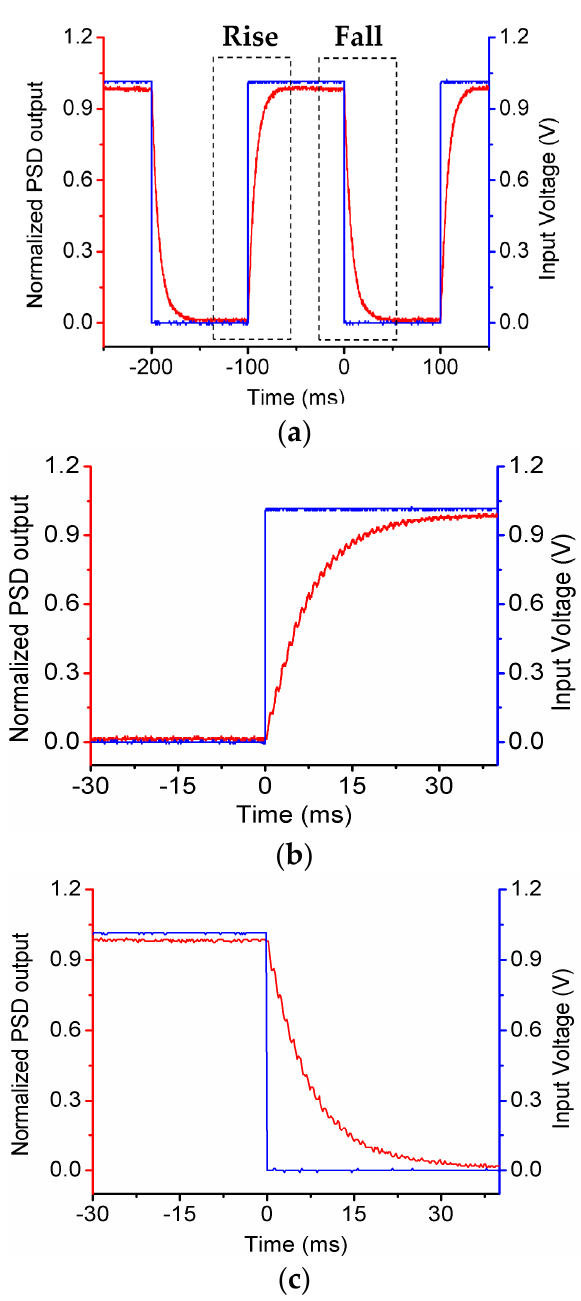
Figure 9. ( a ) Step response of the MEMS mirror; ( b ) Zoom-in picture of the rise time (heating up); ( c ) Zoom-in picture of the fall time (cooling down).